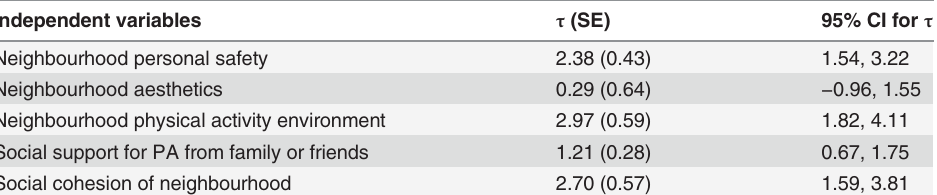
Table 2. Main effects ( τ [SE])of physical and social environmental perceptions on mental health-relat- ed quality of life. Independent